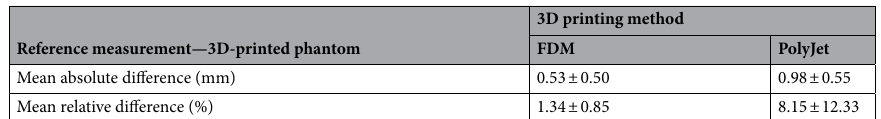
Table 3. Comparison of the reference measurements between the two types of 3D-printed phantoms. FDM fused deposition modeling.